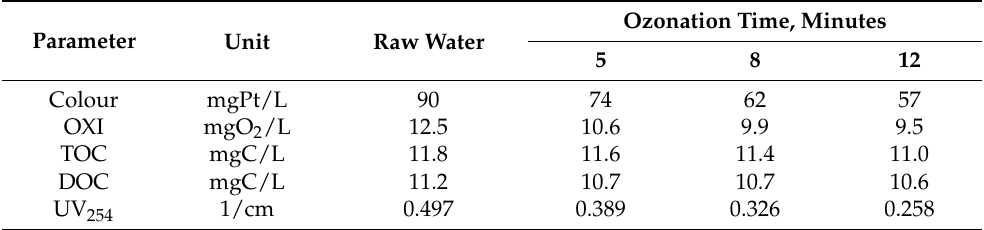
Table 3. Values of selected parameters of raw natural water and water after ozonation process, ozone dose 2 mgO 3